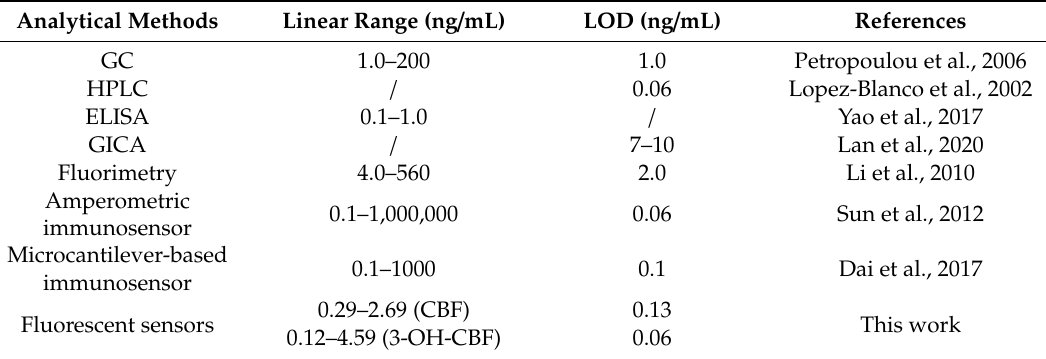
Figure 4. Calibration curves of the developed biosensor against CBF and 3-OH-CBF, separately. R 2 = 0.98 for CBF and 0.99 for 3-OH-CBF, respectively. Each data represents the average intensity with S.D. in triplicates. Table 1. Comparison of different methods for the carbofuran detection.